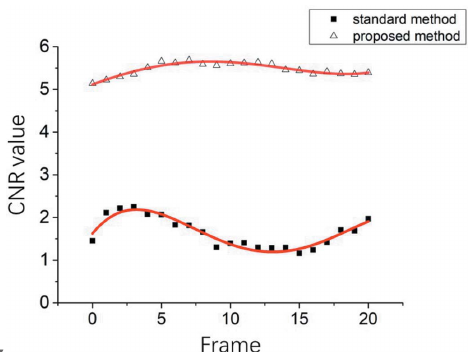
Figure 7 CNRs of the image sequence obtained continuously after the perfusion of contrast agent stabilized. The lower and upper curves correspond to the results obtained using the temporal subtraction method and proposed PTA method, respectively.